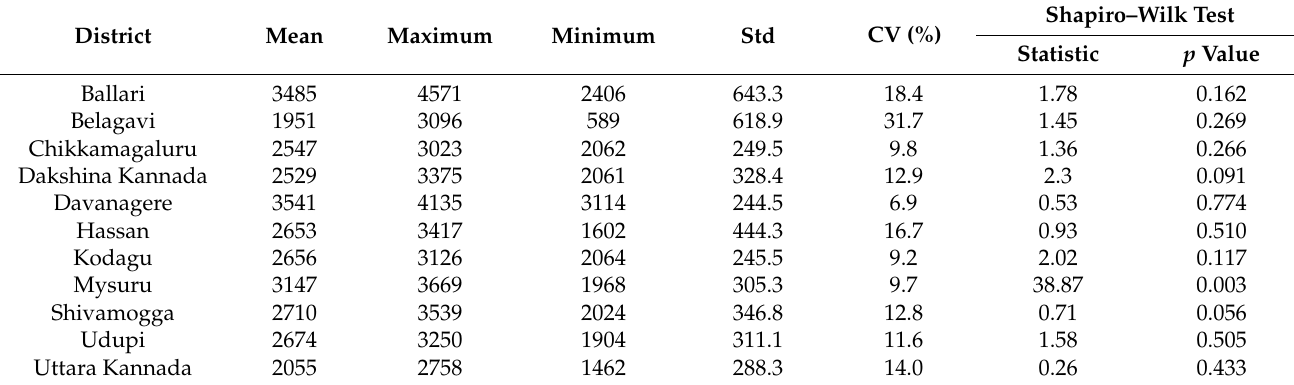
Table 3. Statistics of rice yield variability in eleven study